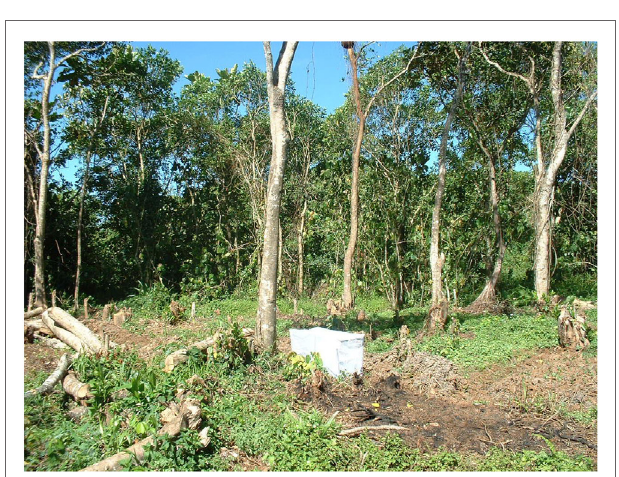
FigUre 2 | remnants of indigenous forest undergoing deforestation, in the foreground is a drainage ditch with an emergence trap for estimating relative habitat productivity